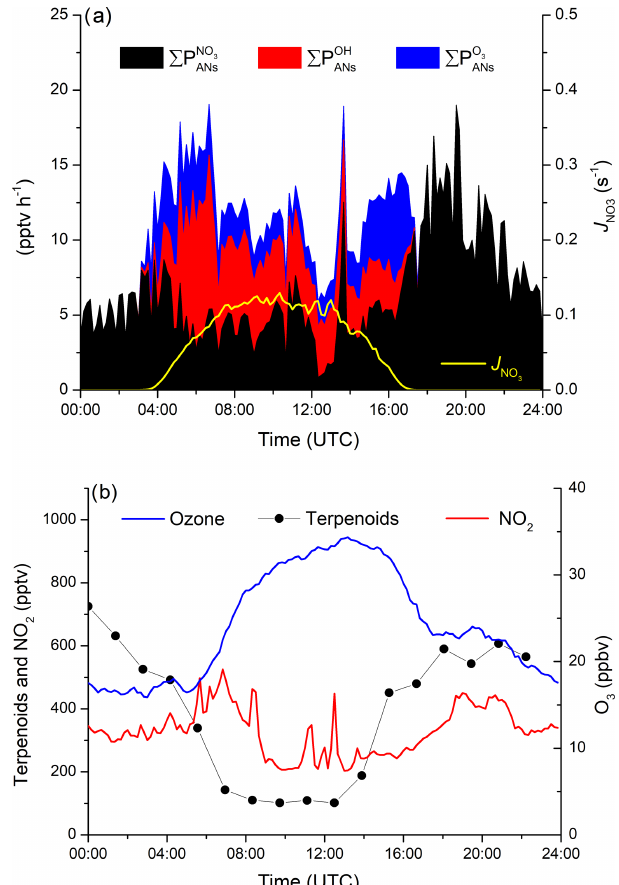
Figure 4. (a) Diel profiles (means) of the AN production rates for VOC initiated oxidation by the OH radical ( (cid:54)P OH and the NO 3 radicals ( (cid:54)P NO 3 NO 3 (yellow line) to distinguish in between night and day. (b) Diel profiles (means) of the mixing ratios of O 3 , NO 2 and total ter-